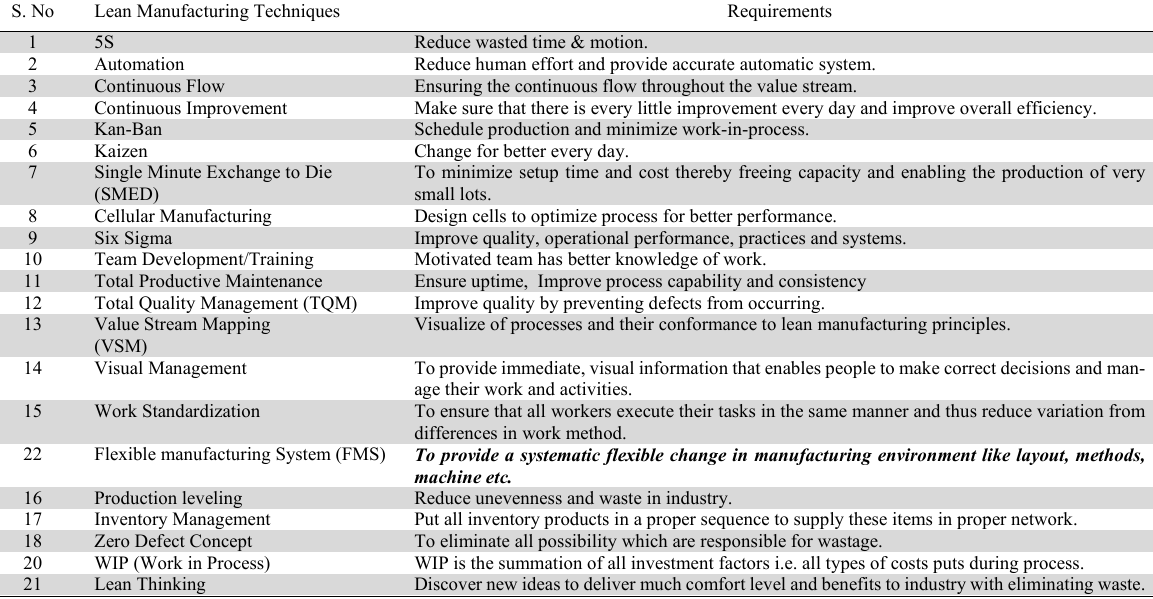
The summary of lean manufacturing techniques and requirements